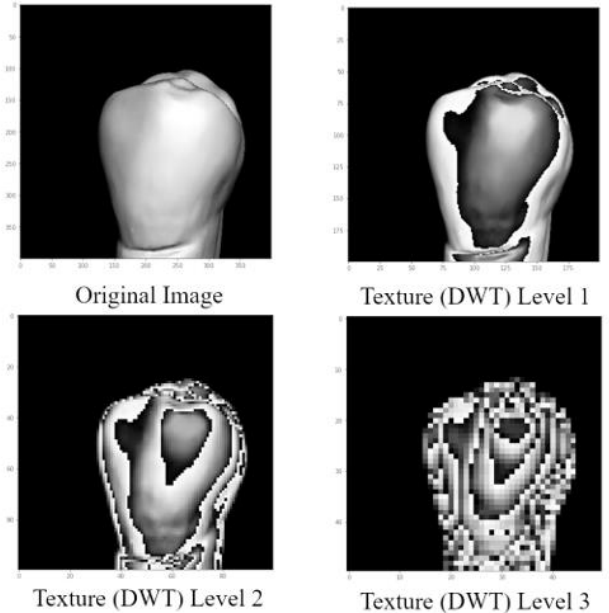
Figure 2. Levels of discrete wavelet transform (DWT) texture extraction. Experiments of three dif- ferent texture levels (level 1, level 2, and level 3), to reach the highest